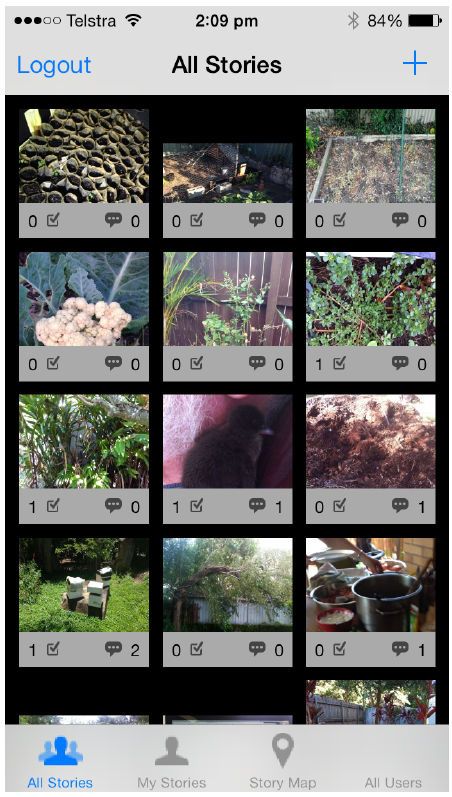
Figure 1. QuickTales application screenshots: Browsing stories by grid